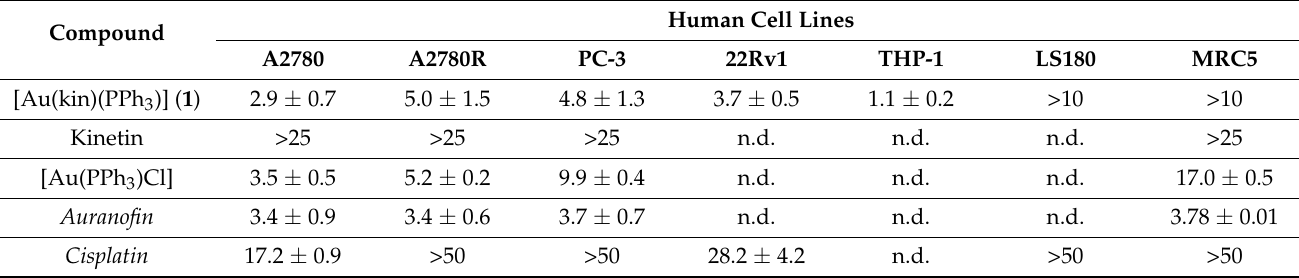
Table 2. The results of in vitro cytotoxicity against selected human cancer cell lines (A2780, A2780R, PC-3, 22Rv, THP-1, and LS180) and healthy (MRC5) cells. IC 50 values are given in µ M together with the standard deviations, and they are based on triplicate experiments. The abbreviation n.d. means that the value has not been determined.